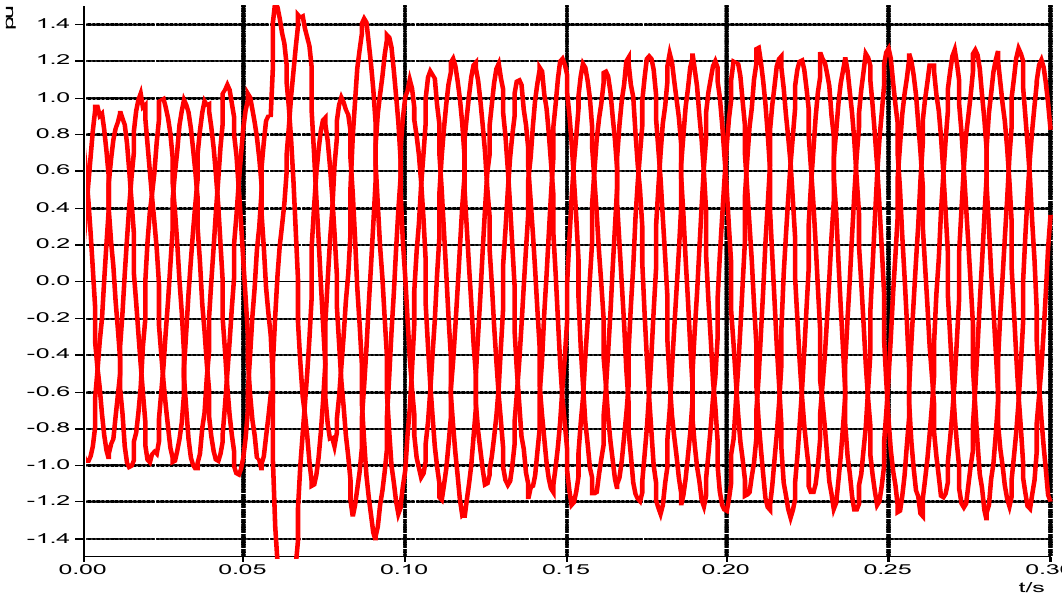
Figure 22. Instantaneous value of the main current I grid .